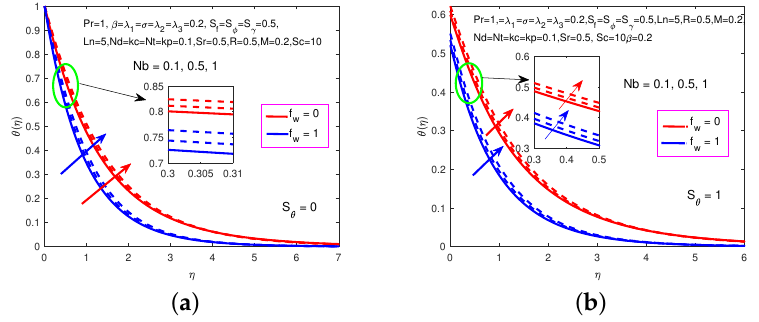
Figure 9. Influence of Nb and f w on θ . ( a ) No thermal slip. ( b ) With thermal slip.